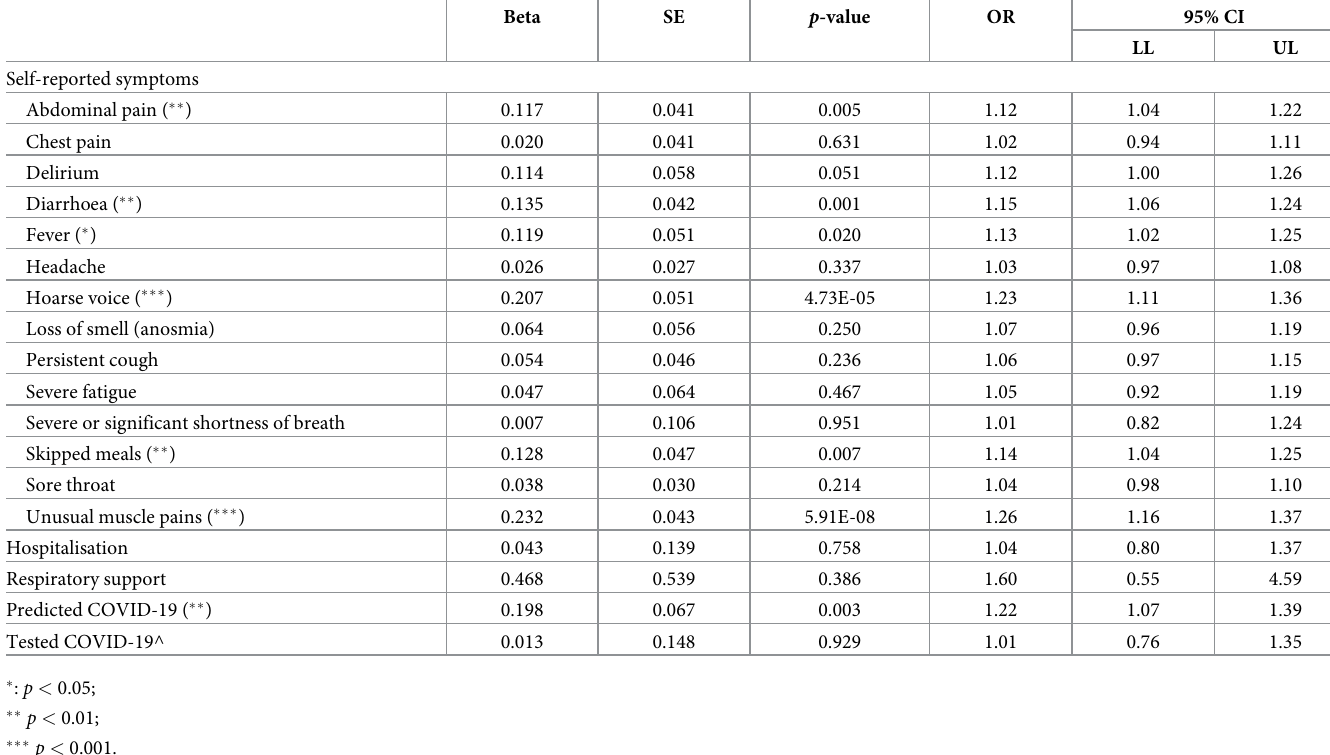
Table 1. Association of menopausal status to predicted and tested COVID-19 results, self-reported symptoms and indicators of COVID-19 disease severity (hospi- talisation/respiratory support) (n = 152,637). Beta SE p